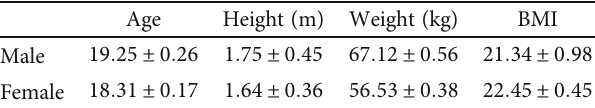
Table 1: Basic information of